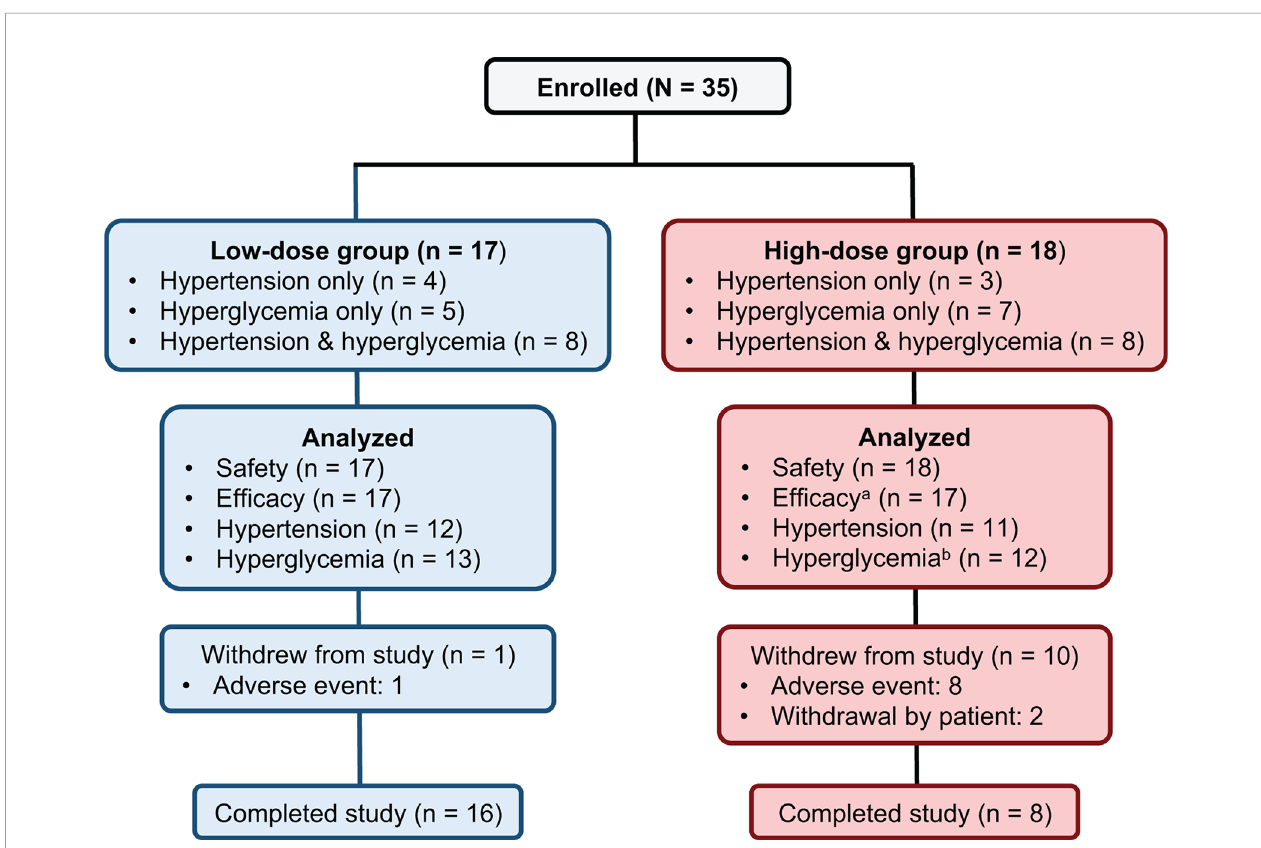
FIGURE 2 | Patient disposition. a One patient in the high-dose group did not have any postbaseline data and was excluded from the ef fi cacy population. b Two patients in the high-dose hyperglycemia group did not have any postbaseline ef fi cacy data while on study drug and were excluded from the hyperglycemia